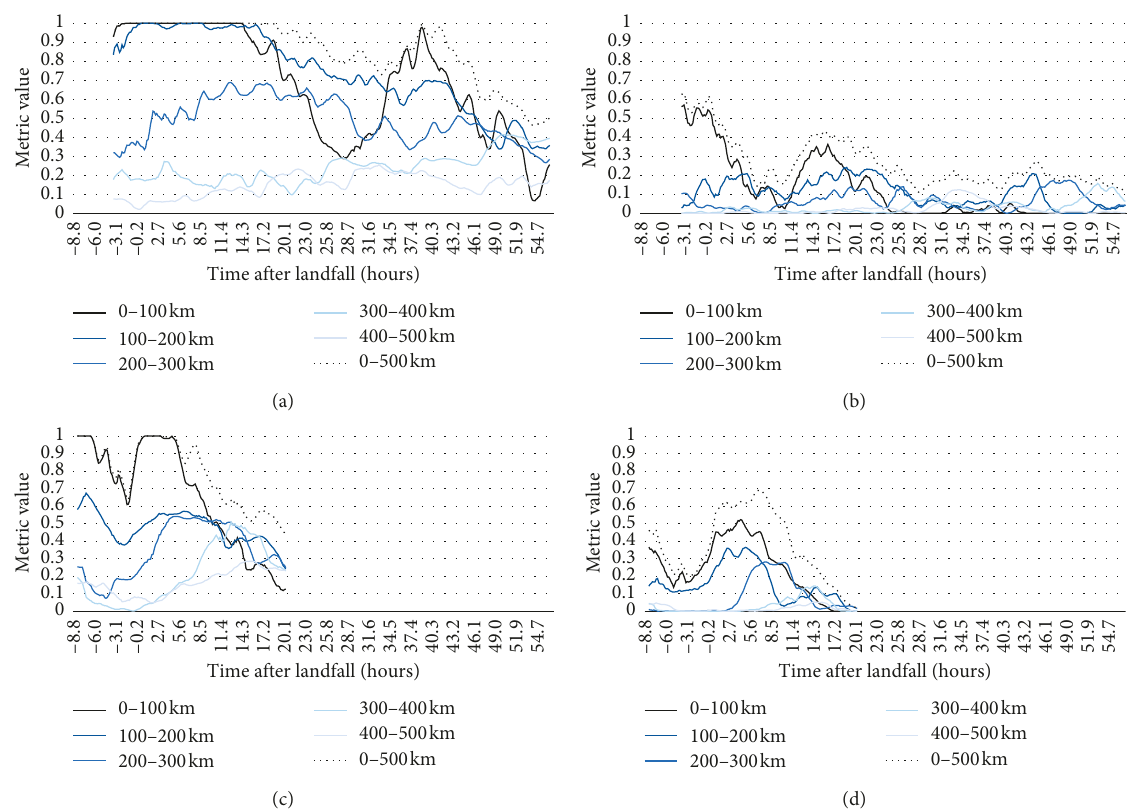
Figure 7: Closure values calculated over six ranges outward from the circulation center (km) for (a) Jeanne 20dB Z , (b) Jeanne 40dB Z , (c) Humberto 20 dB Z , and (d) Humberto 40dB Z regions. Stippled black lines correspond to the same lines in Figure 5.